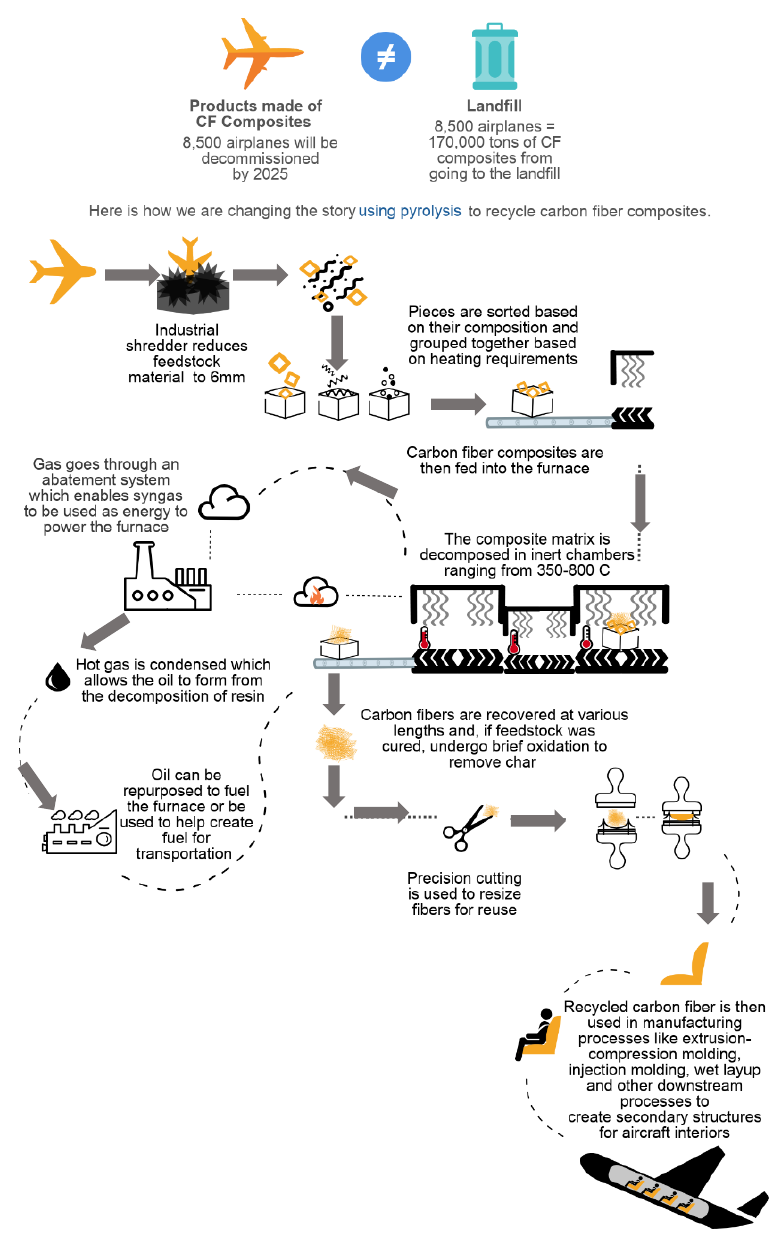
Figure 1. The pyrolysis process when applied to aerospace CFRP to promote circularity. Figure 1 . The pyrolysis process when applied to aerospace CFRP to promote circularity .